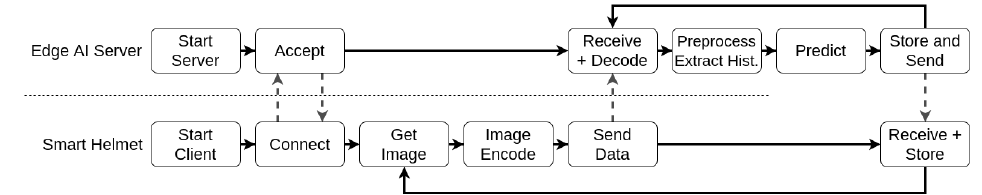
Figure 6. Edge AI service pipeline. In the proposed architecture, clients perform part of the processing, while the AI pipeline is provided by the edge AI server node.